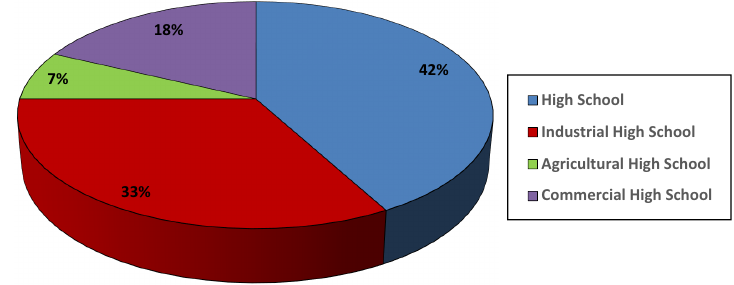
Figure 2. Percentage